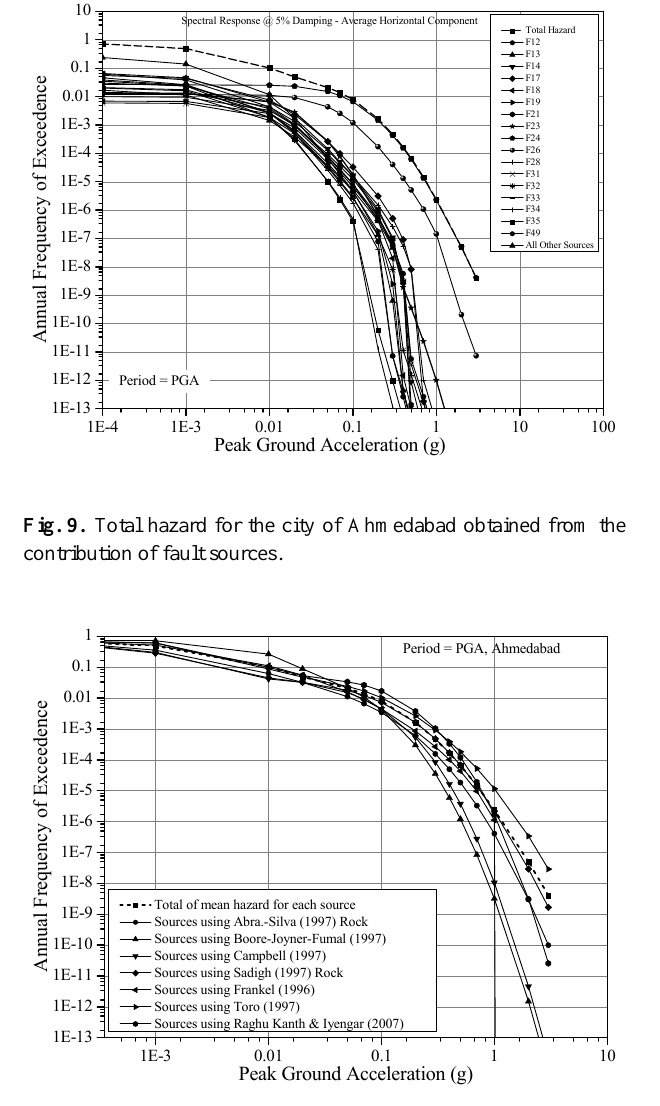
Fig. 10. Comparison of ground motion attenuation relations Figure 10. Comparison of ground motion attenuation relations (GMARs) computed using 4 (GMARs) computed using various models for total hazard for the various models for total hazard for Ahmedabad city 5 city of